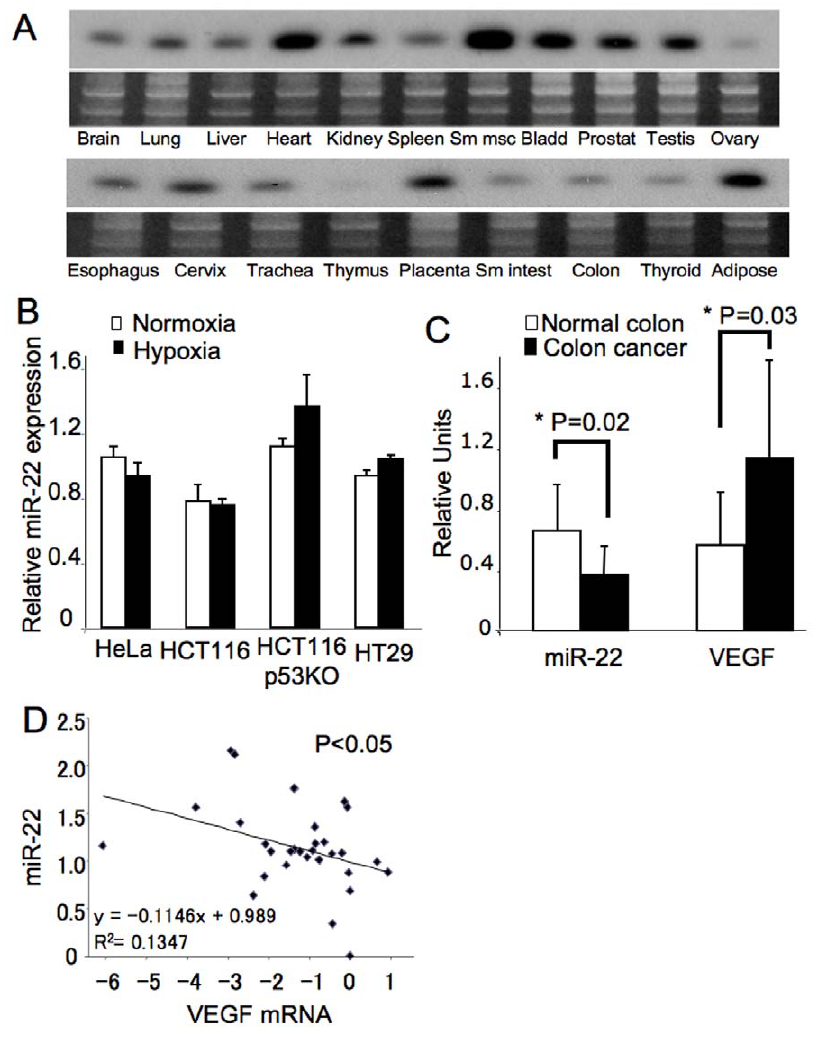
Figure 1. Expression of miR-22 in human cells, normal human colon tissue and human colon cancer. (A) MiR-22 expression in normal human tissues. A commercial membrane containing RNA from normal human tissues was probed for miR-22 using Northern analysis. (B) MiR-22 expression in cell lines. Cell lysates were probed for miR-22 by Northern blotting. (C) MiR-22 and VEGF expression in normal human colon tissue and human colon cancer. RNA was extracted from 9 normal human colon specimens (white) and from 9 human colon cancer specimens (black), and analyzed by qPCR for miR-22 and VEGF expression (n=9 6 S.D.). Colon cancer specimens contain less miR-22 and more VEGF than normal colon specimens. (D) The association of miR-22 and VEGF in human colon cancer. Natural log transformation of relative ratio of RNA for miR-22 and VEGF was used for statistical analysis (n=30).